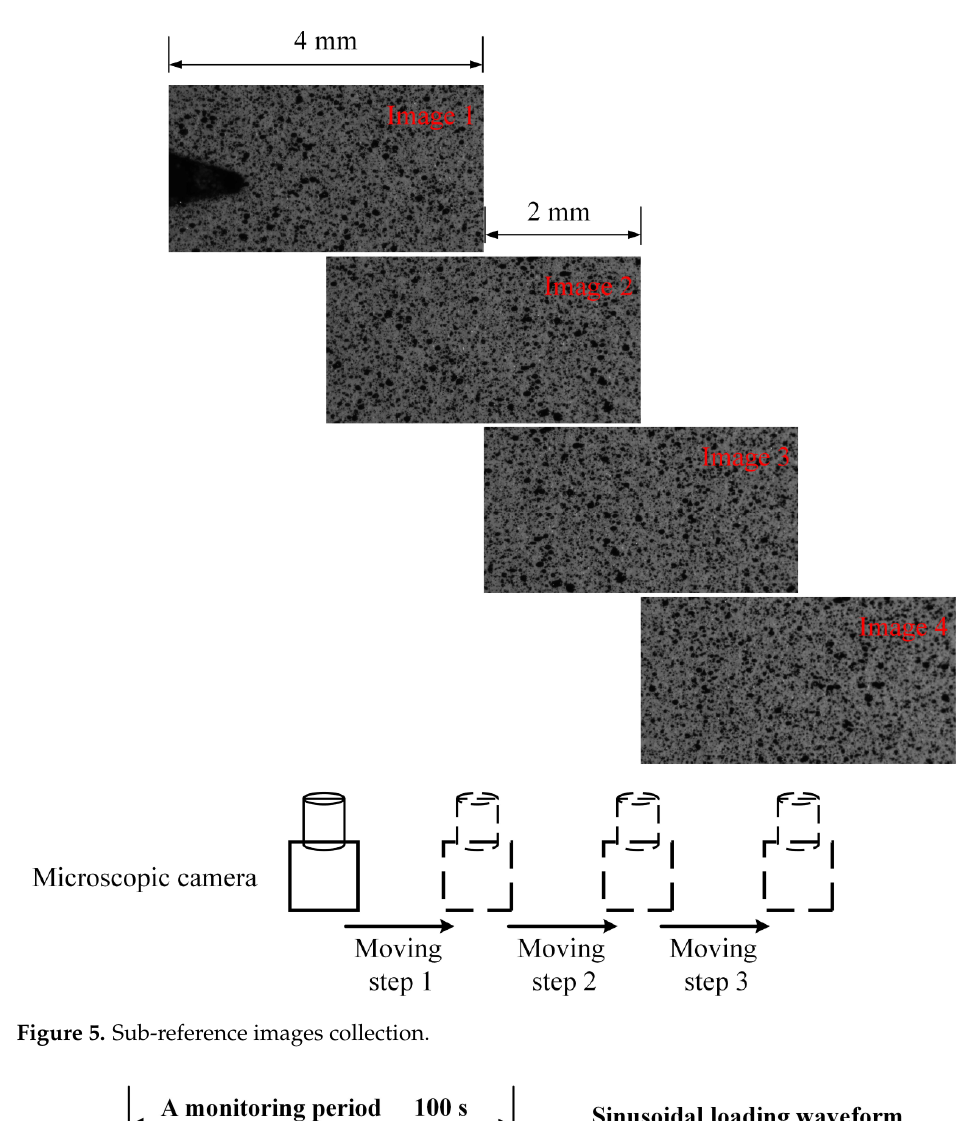
Figure 5. Sub-reference images collection.